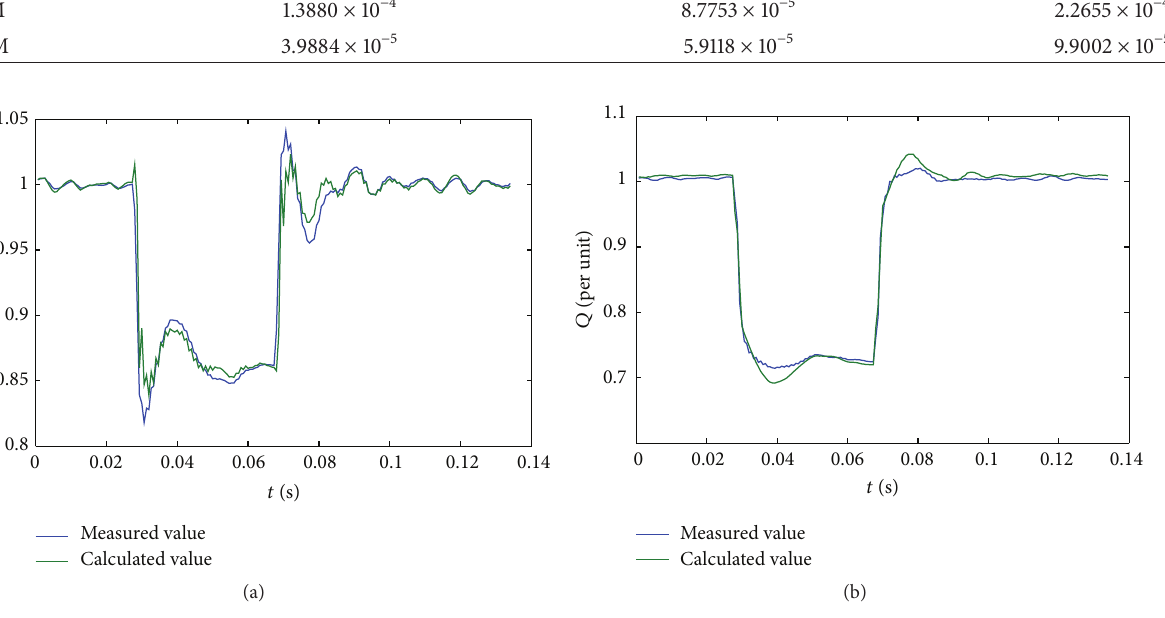
Figure 8: Power fitting curves of TPSLM.